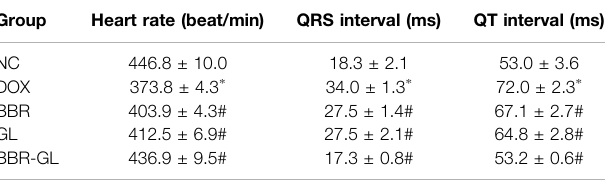
TABLE 5 | In fl uence ofBBR and BBR – GL on ECG parameters ofrats treated with DOX. * p < 0.05 vs. NC group; # p < 0.05 vs. DOX